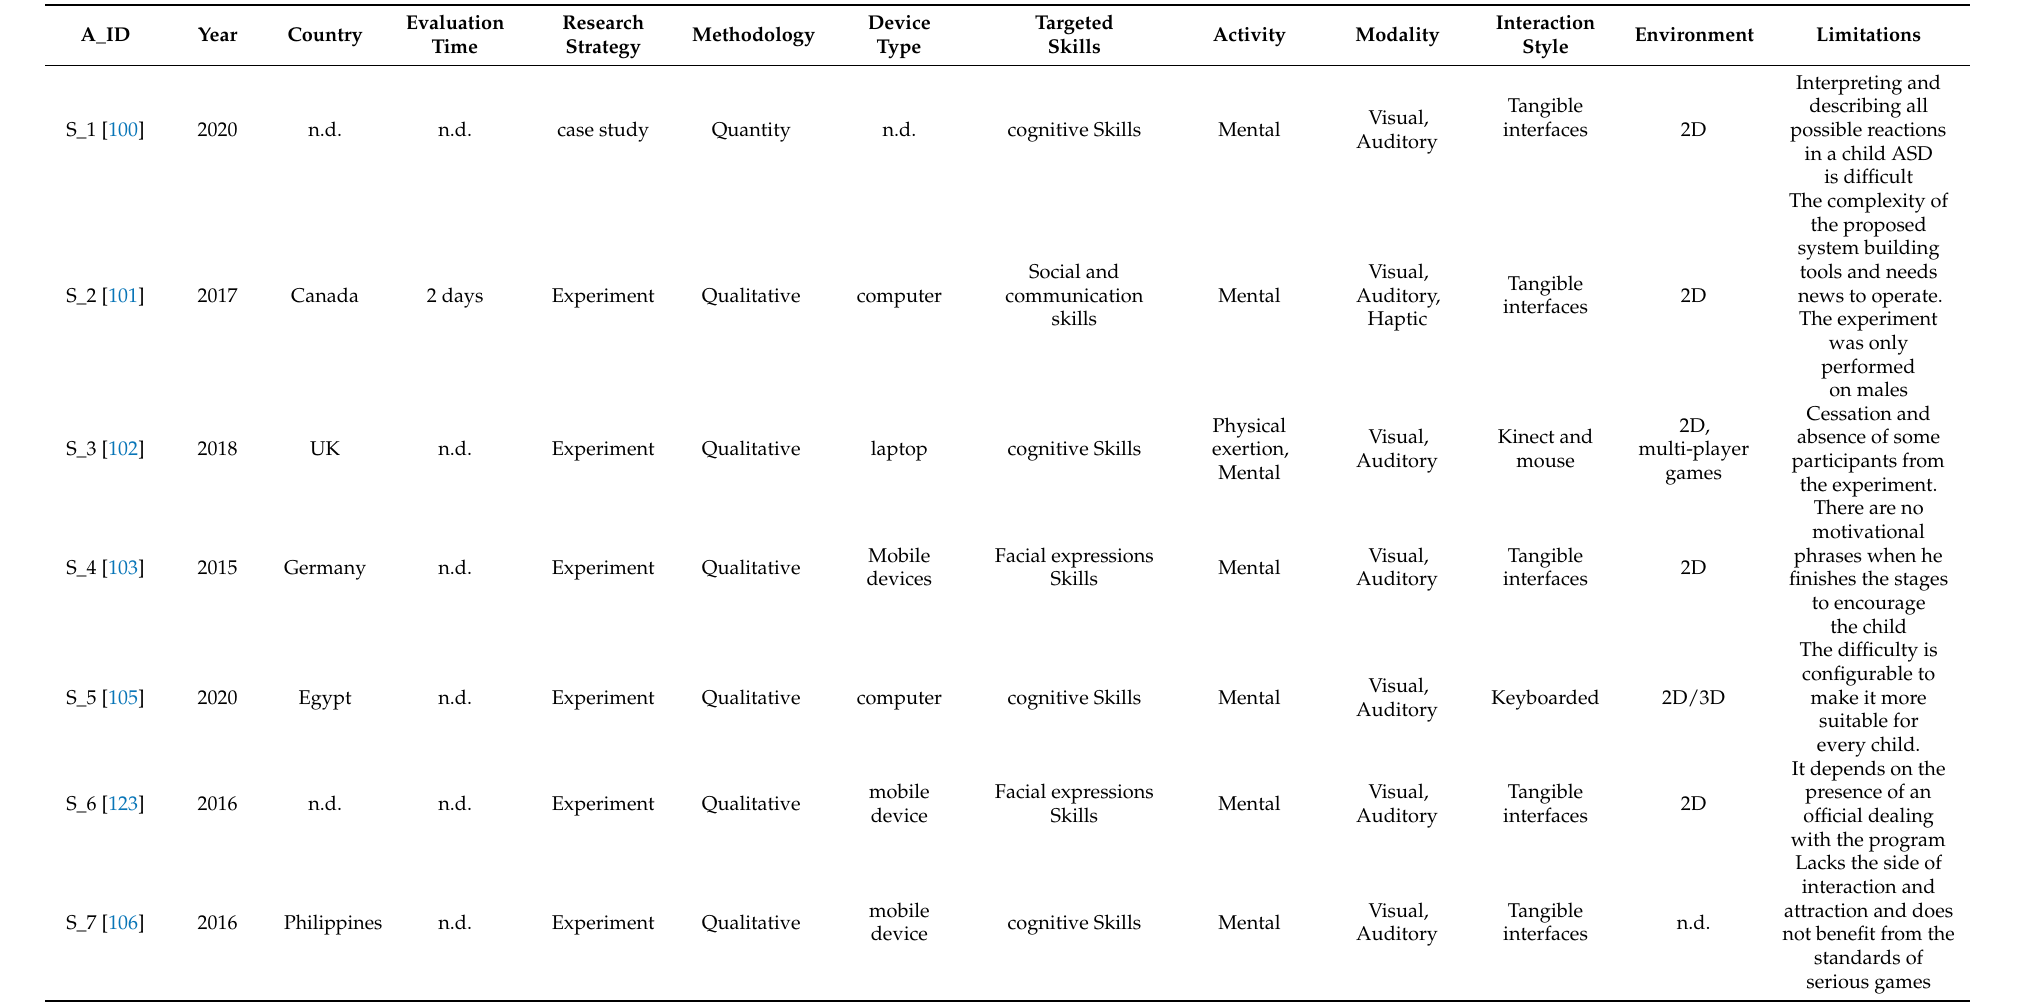
Table 9. The related studies of serious games with